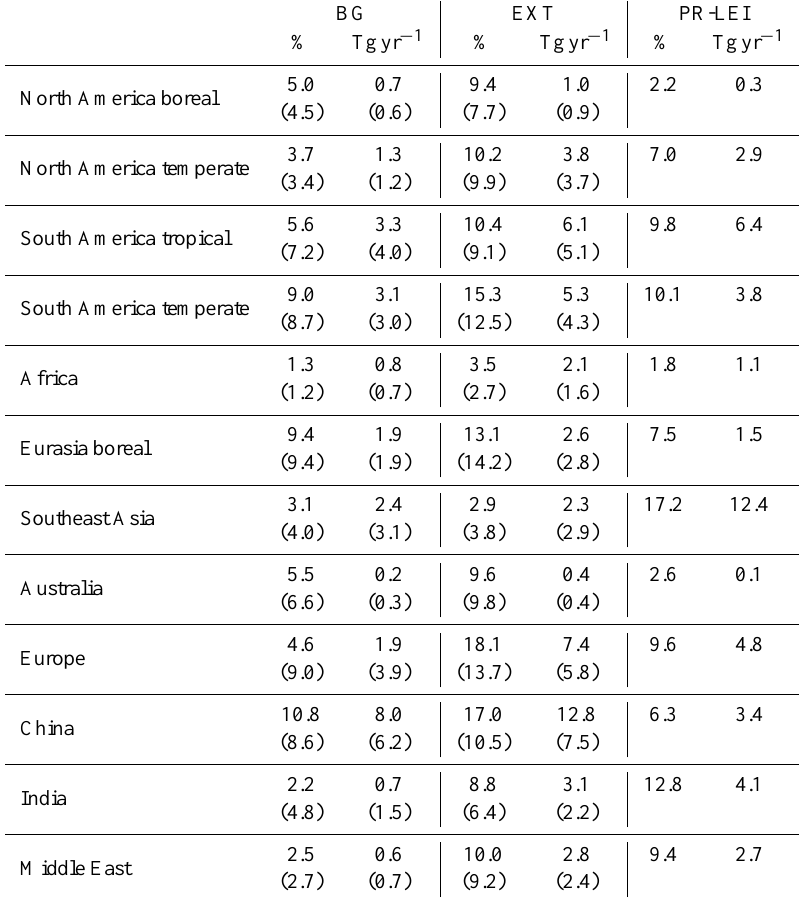
Table 2. Spreads of regional methane flux (maximum − minimum of CH 4 emissions) in BG, EXT and PR-LEI inversions due to changes in physical parameterizations. The spread is expressed in percent and inTgCH 4 year − 1 . The numbers are relative to the common year of inversions, which is 2010. However, average spreads between 2007 and 2011 are also shown for BG and EXT inversions (inside the parentheses) since surface-based inversions have been run for several